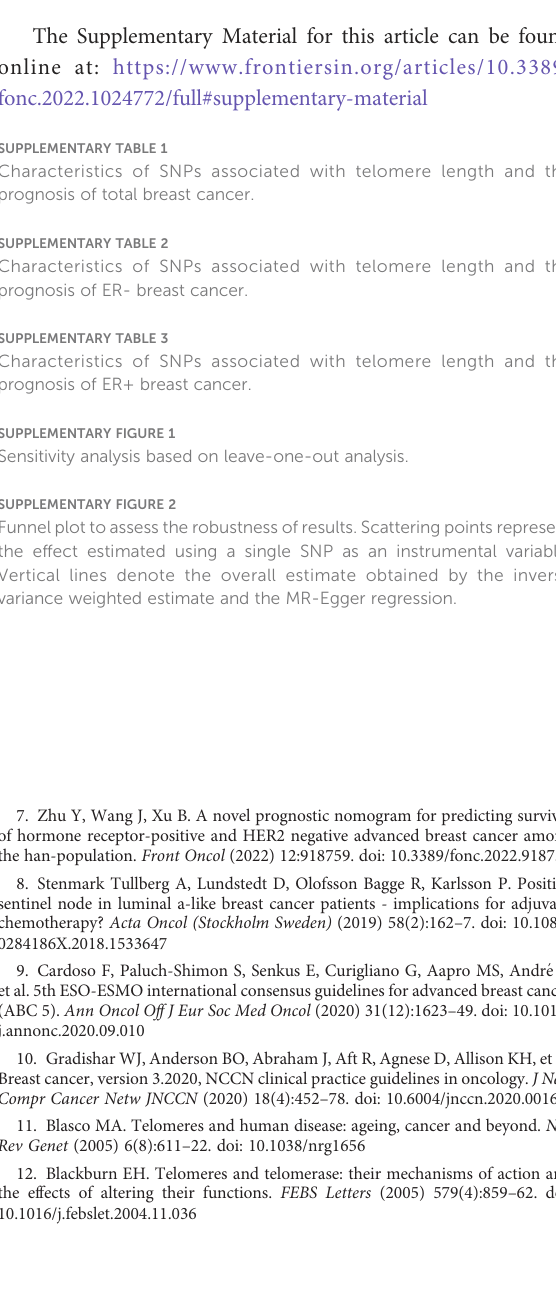
prognosis of total breast cancer.